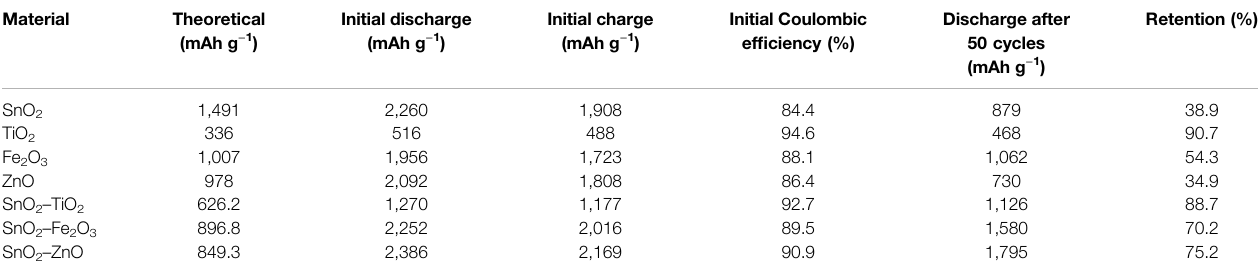
TABLE 3 | The theoretical, initial charge-discharge capacity, Coulombic ef fi ciency, the discharge capacity after 50 cycles at 1 ° C and the retention rate of all the investigated thin- fi lm electrodes. Material